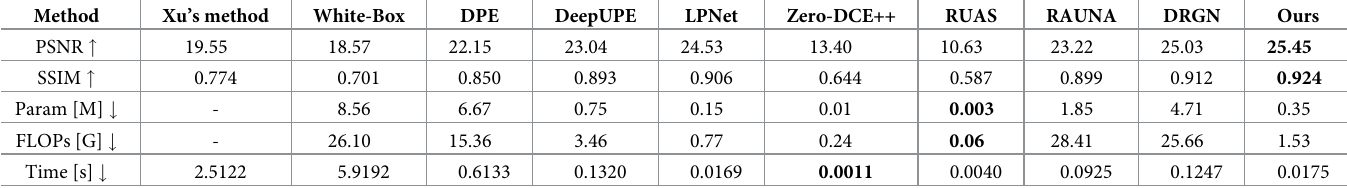
Table 2. Quantitative comparison on MIT5K dataset.